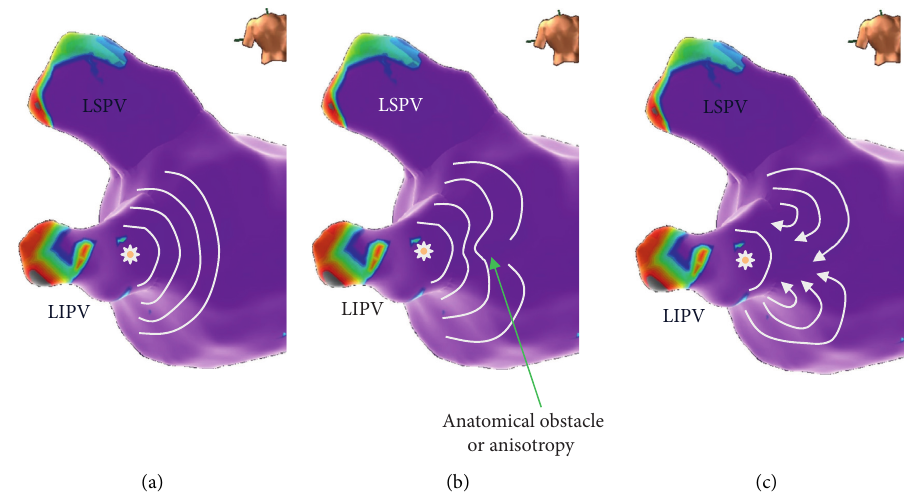
Figure 2: (a) The arrhythmic firing from the left inferior PV propagates normally to the atrial myocardium. (b, c) Special conditions such as conduction anisotropy or anatomical obstacle at the central point of the wavefront can create two waves with rotational propagation, capable of maintaining AF.